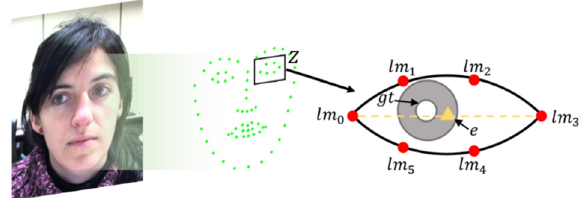
Figure 2. Six eye landmarks used for estimating the starting pupil position. The starting pupil position ( e ) of the eye is assigned to the middle location of both eye corners ( lm 0 and lm 1 ), and the displacement ( ∆ d ) vector is computed using distance L 1 between a given ground truth ( gt ) and the predicted pupil position.